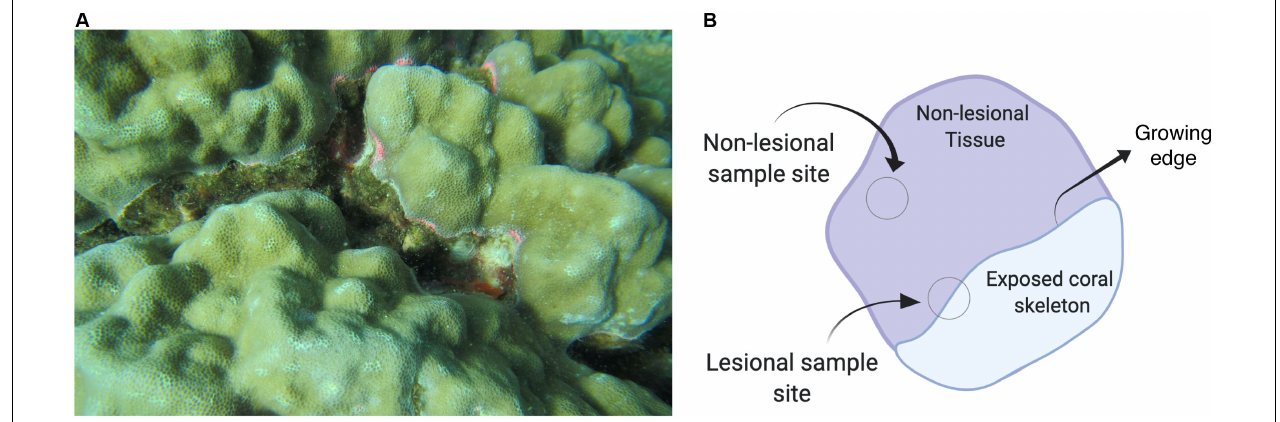
FIGURE 2 | (A) Porites spp. This image shows a lesioned Porites coral. The diseased coral has a blotch of skeleton visible (covered by algae) where the growing edge is receding and shows signs of an immune response. Photos were taken by Kristín Rós Kjartansdóttir and Thomas Arn Hansen. (B) Image depicting the location of where samples were taken from. Image created with